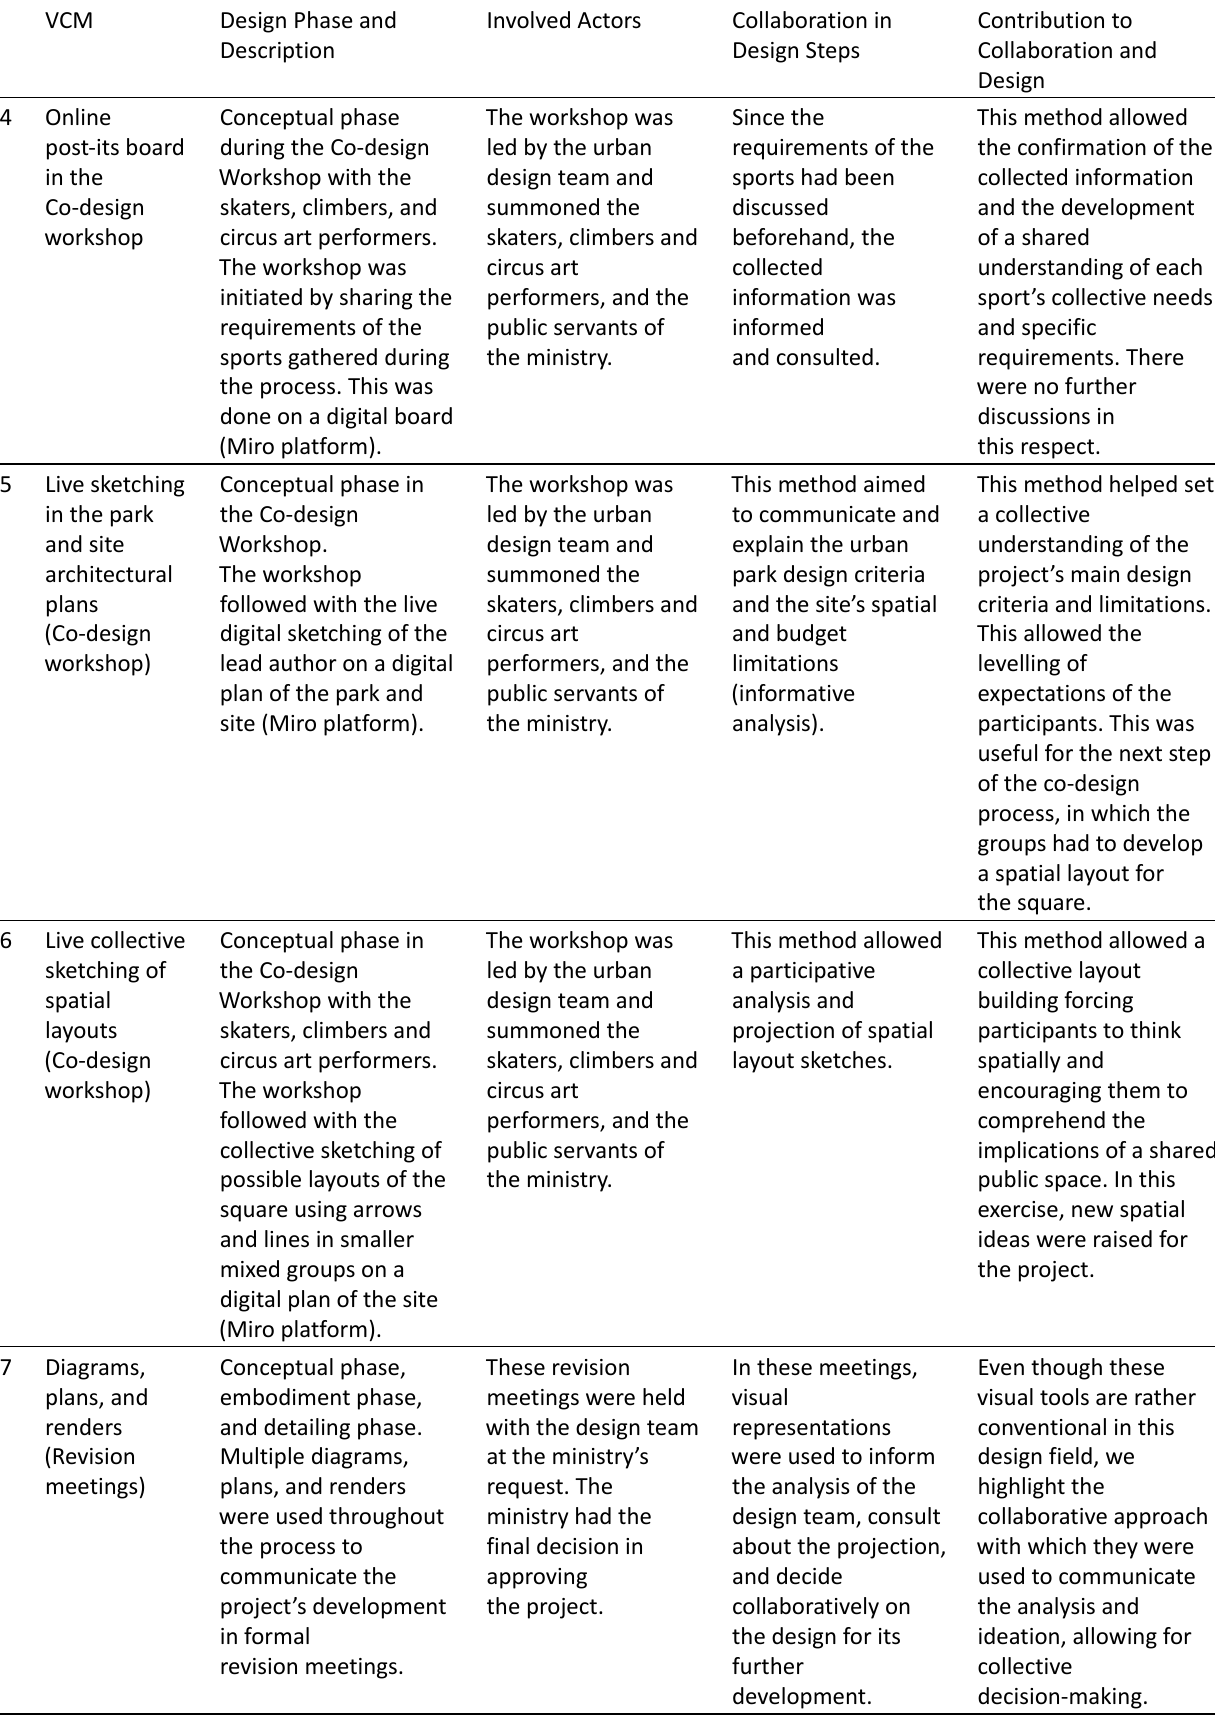
Table 2. (Cont.) VCMs used in the design